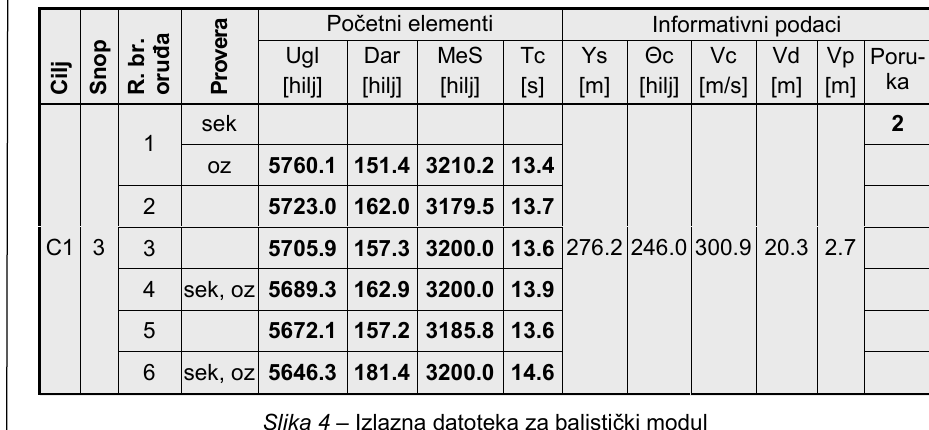
Figure 4 – Output database for the ballistic module